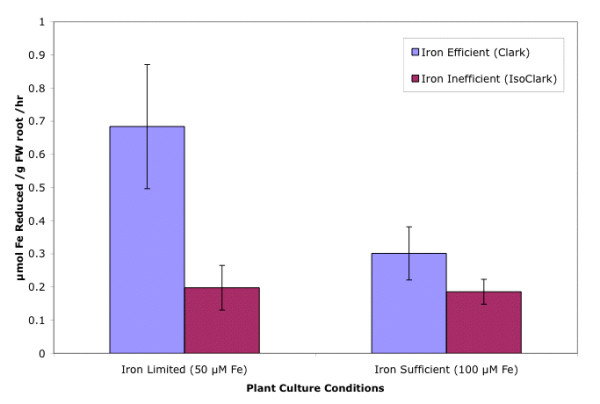
Whole Root Reductase Assay Results Across Various Iron Concentration Growth Conditions. The iron efficient Clark plant shows a statistically significant increase in reductase activity at 50 uM Fe(NO3)3, iron deficient conditions for the microarray experiment. At the same iron concentration, the iron inefficient IsoClark shows low levels of reductase activity.